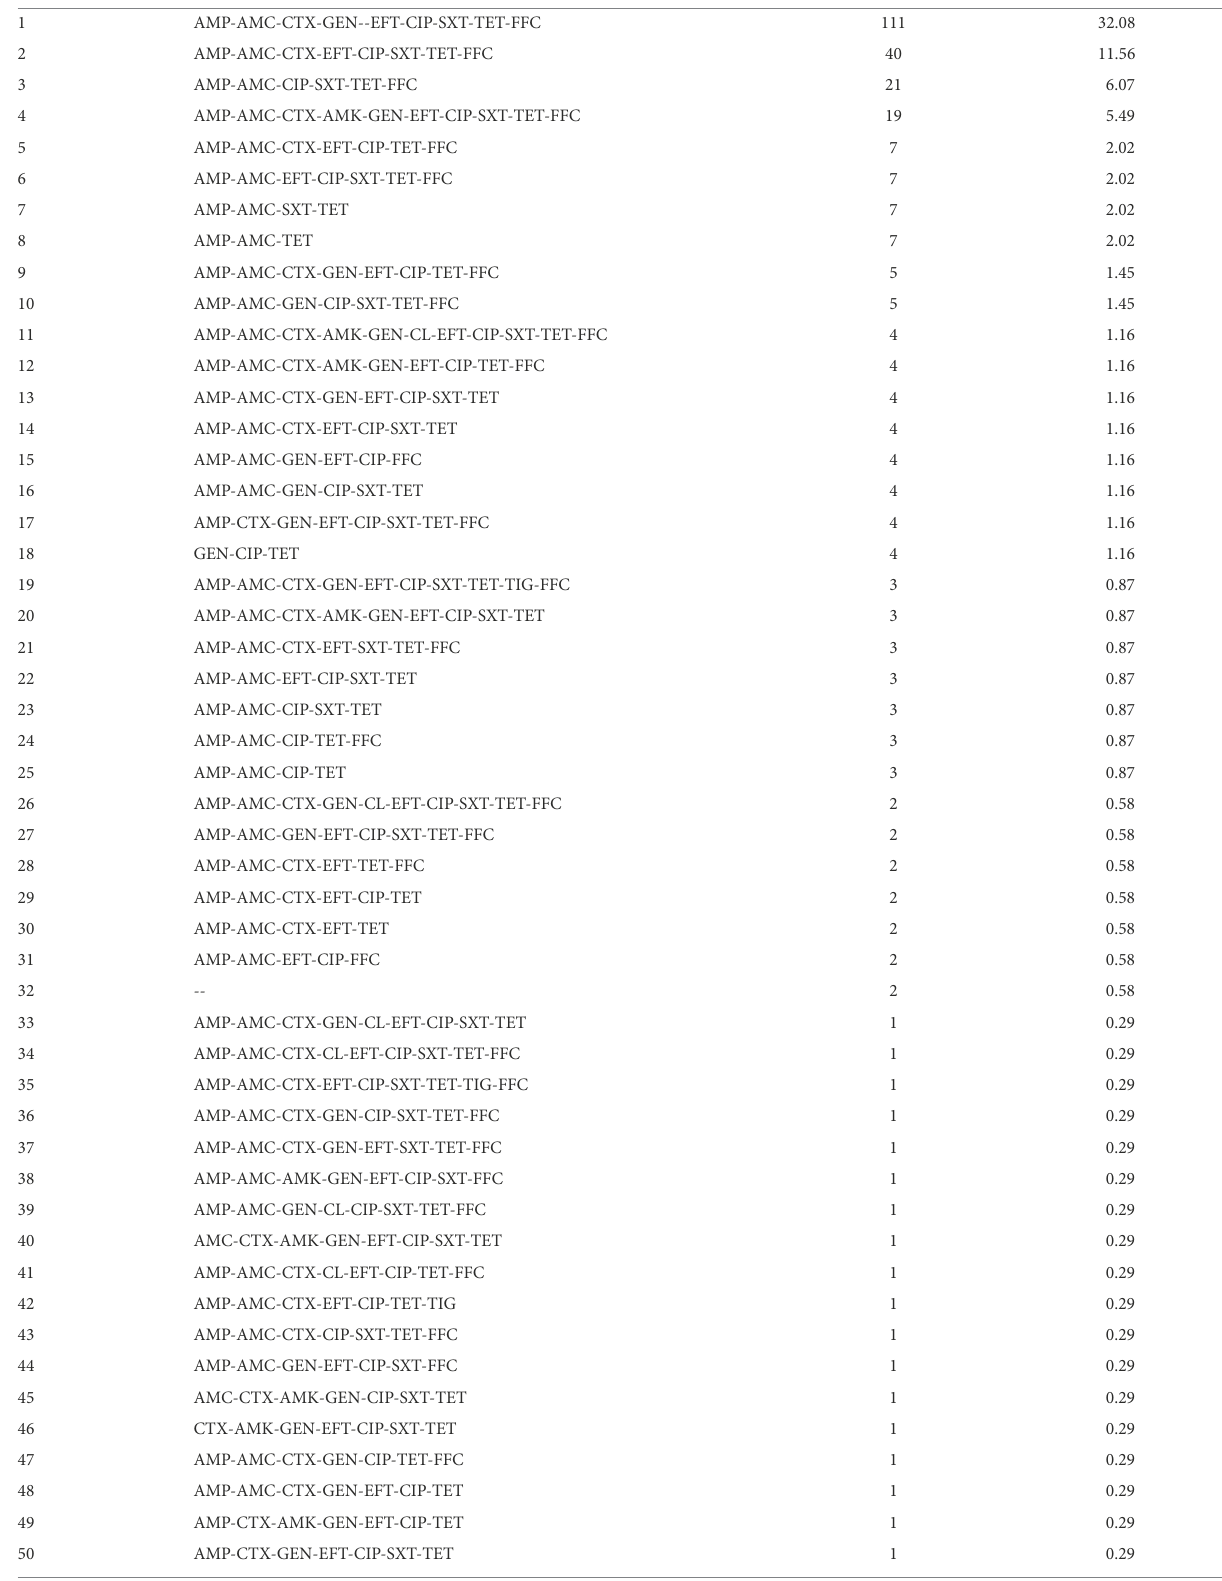
TABLE 1 Antimicrobial resistance profiles of 346 Escherichia coli